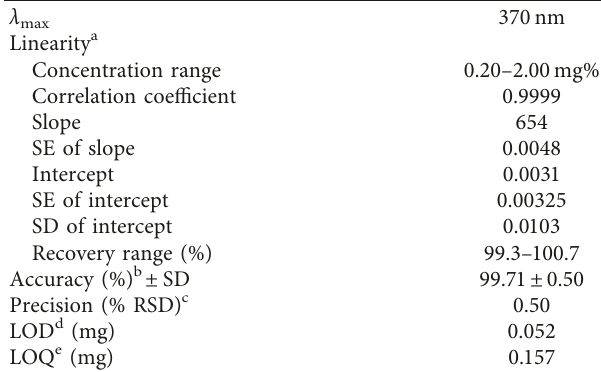
Table 2: Analytical parameters for the assay of thiochrome (TC).